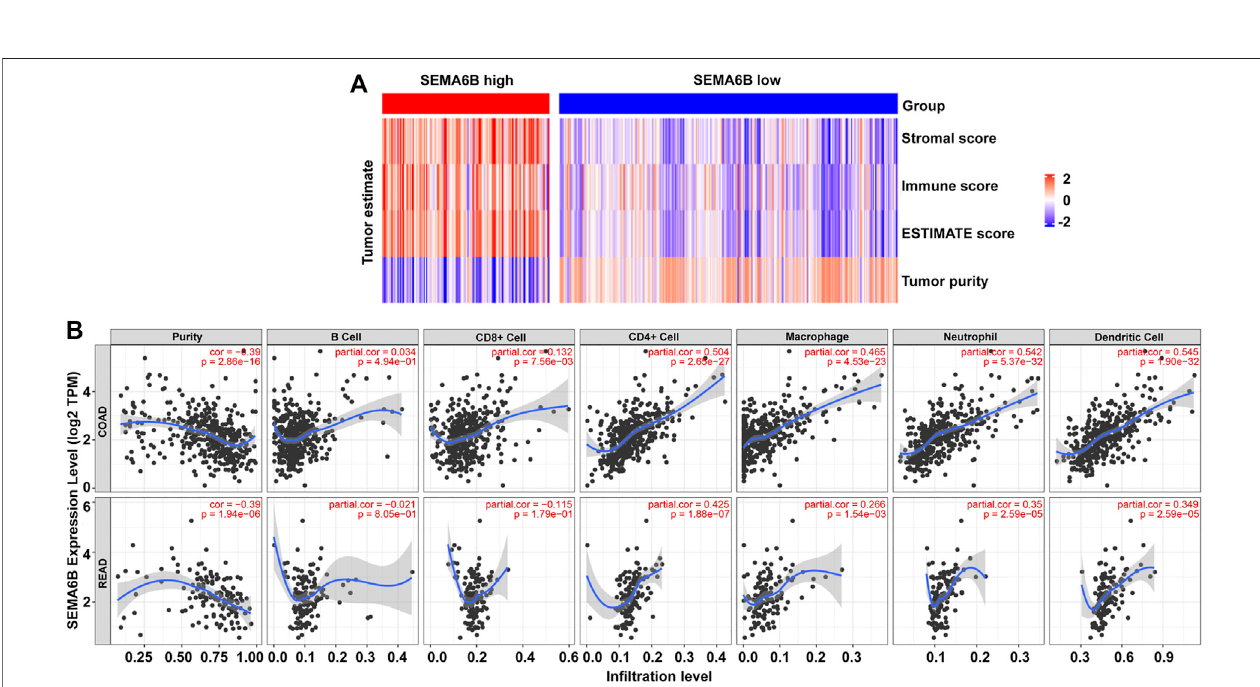
FIGURE 8 | SEMA6B expression is correlated with immune in fi ltration in CRC patients. (A) Heatmaps of immune scores, stromal scores, ESTIMATE scores, and tumor purities for each patient between the high and low SEMA6B expression groups. (B) Correlations of SEMA6B expression with tumor purity and immune-cell in fi ltration levels in COAD and READ from the TIMER